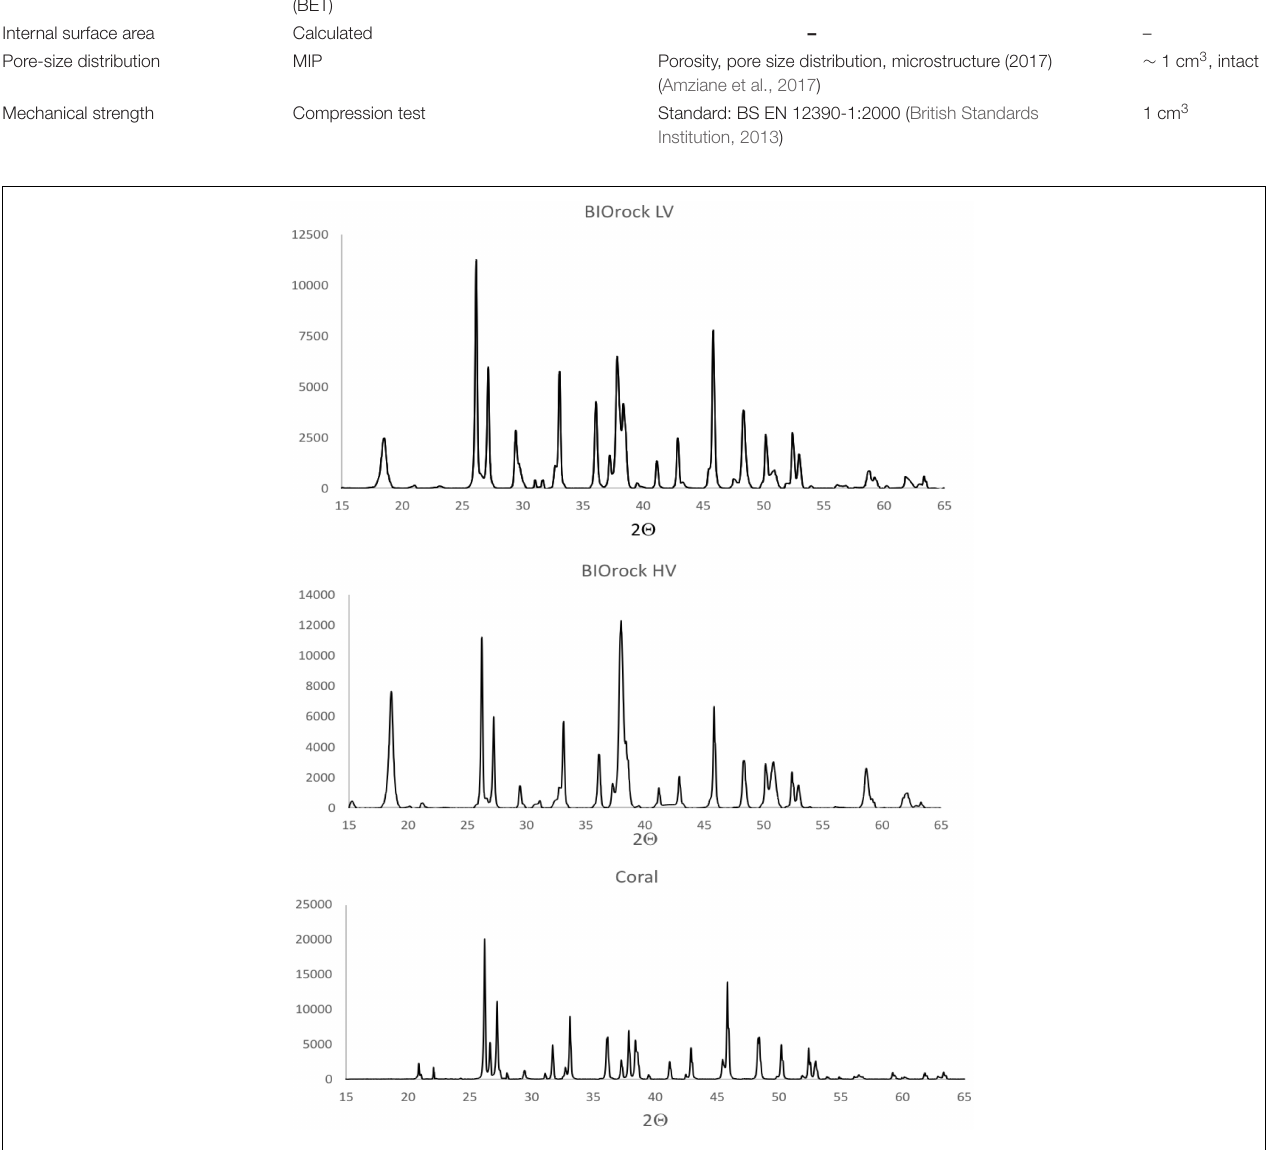
FIGURE 2 | XRD profiles and patterns for the three